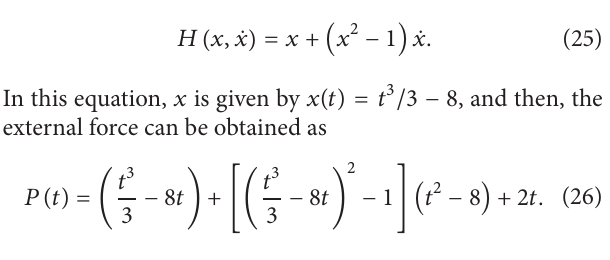
Figure 14: For Example 4, restoring force surface based on the